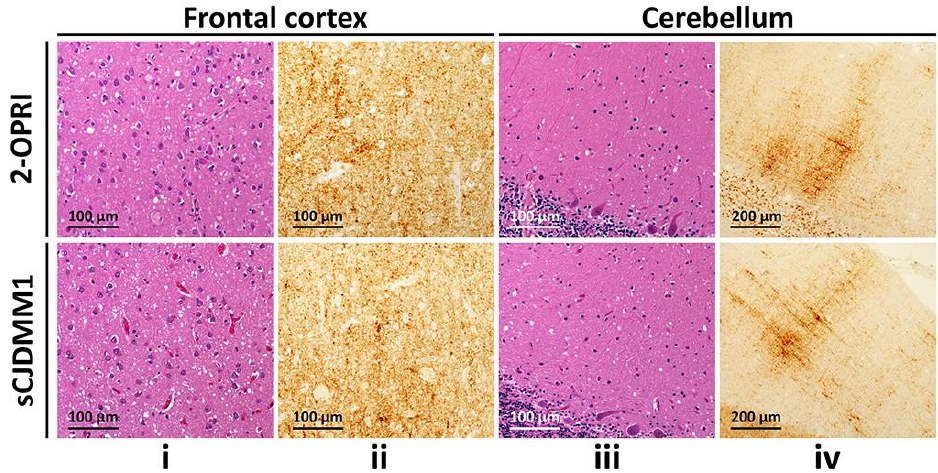
Figure 1. Histological determination of 2-OPRI and sCJDMM1: ( i , iii ): Hematoxylin-eosin staining. ( ii , iv ): PrP immunohistochemistry. ( i , iii ): Fine spongiform degeneration. ( ii , iv ): Diffuse PrP immunostaining ( ii , iv ) with the typical “brush stroke-like” deposits in the cerebellar molecular layer ( iv ); antibody: 3F4.